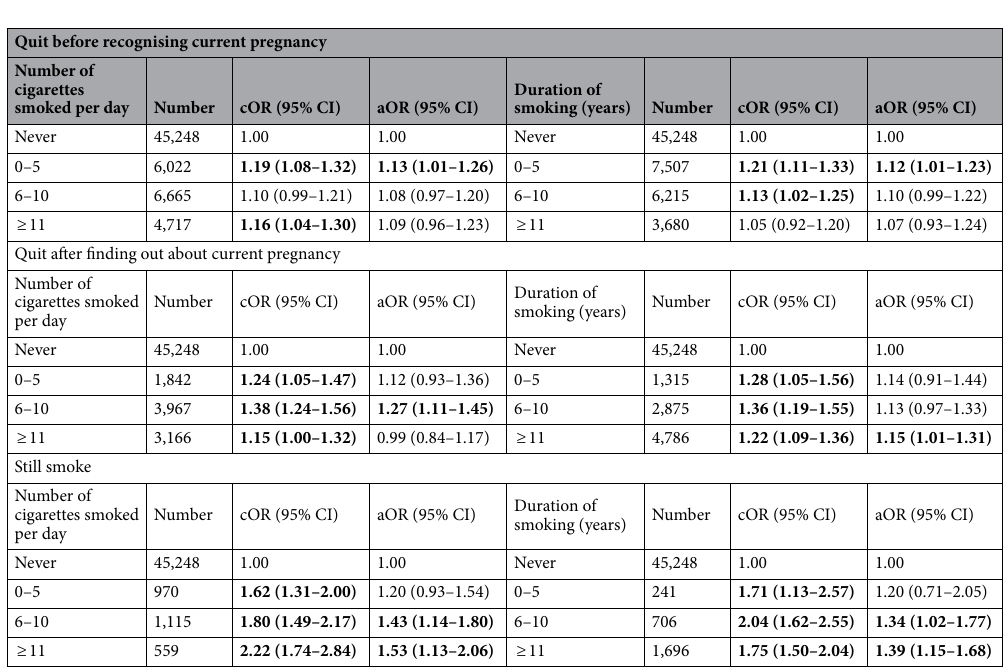
Table 2. Association between smoking exposure and risk of bronchial asthma at the age of 3 years. cOR, crude odds ratio; aOR, adjusted odds ratio; CI, confidence interval. Boldface indicates statistical significance ( p < 0.05). Adjusted for partner’s smoking status before birth, frequency of second-hand smoke exposure during pregnancy, maternal history of bronchial asthma, maternal age at birth, pre-pregnancy body mass index, maternal educational level, child’s sex, gestational age at birth, mode of delivery, attendance to childcare facility at 1 year of age, breastfeeding at 1 year of age, and older